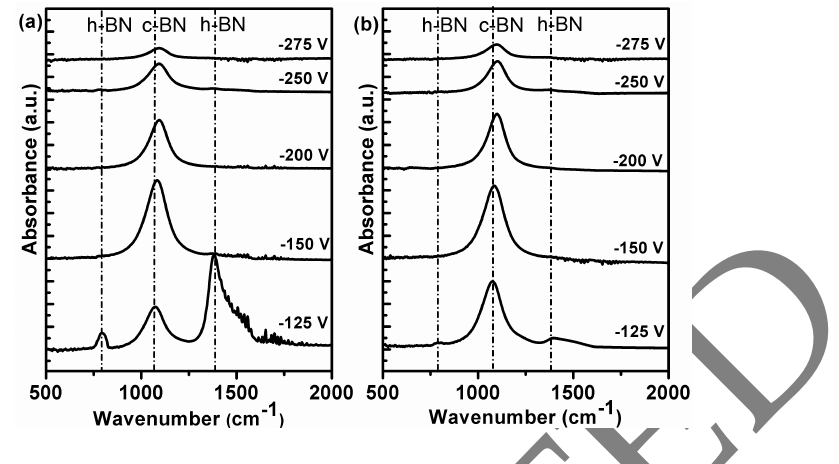
Figure 5. FTIR spectra of a series of c-BN films deposited at various substrate biases from − 125 to − 275 V with ( a ) pure N 2 and ( b ) Ar:N 2 = 1:1 in the working gas after the second step.